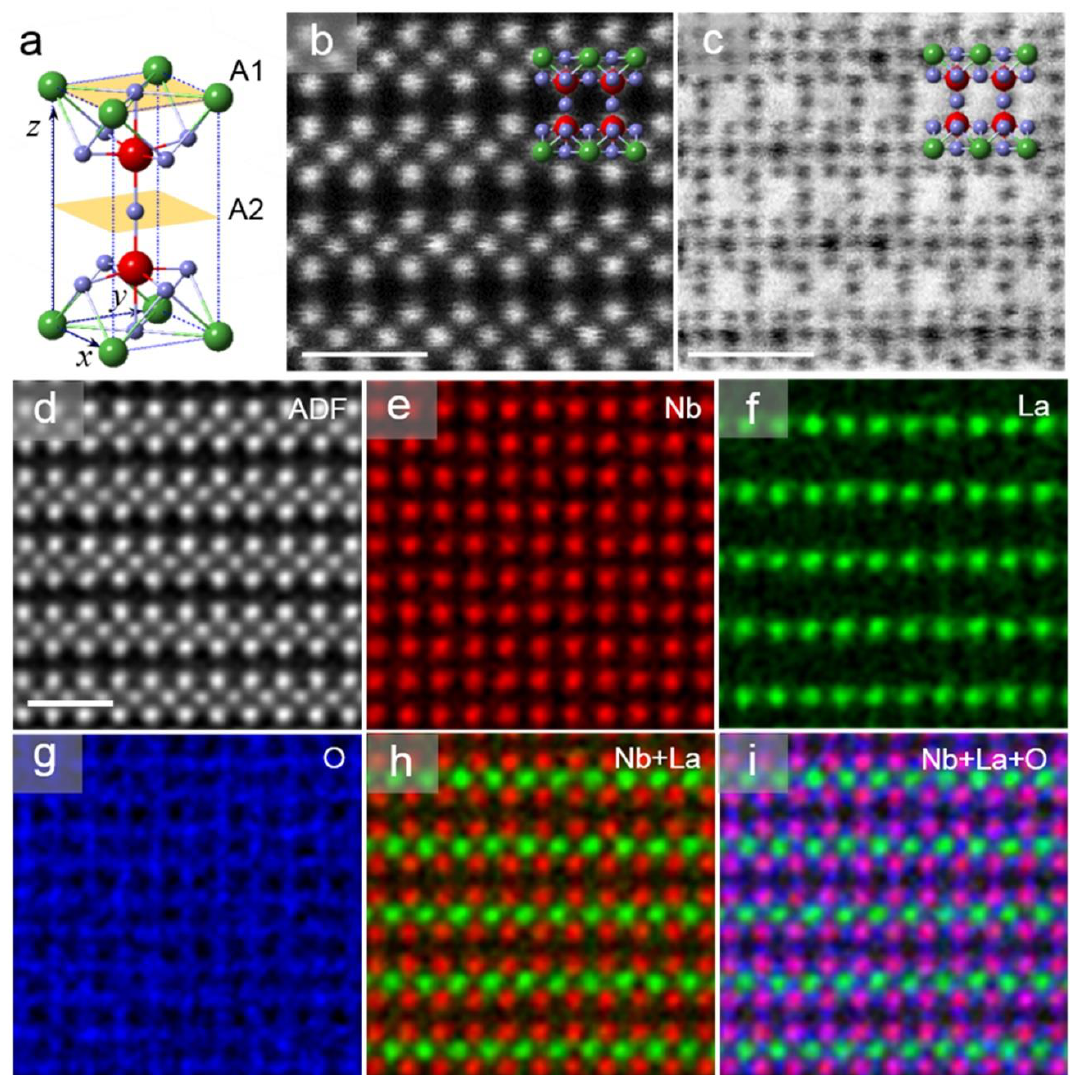
Figure 1. ( a ) Structure model of perovskite electrolyte LLNO. In the unit cell, green atoms stand for coexisting Li, La sites with an occupancy of 2/3, red for Nb with 100% occupancy, and blue for O with 100% occupancy. The A 1 layer marks the La, Li-coexisting layer, and A 2 layer is the “empty” mid-plane gap between A 1 layers. ( b , c ) Atomically resolved HAADF and ABF images in [100] direction, respectively. The atomic models superposed suggest the invisible O atoms can be clearly identified in the ABF image. ( d – i ) STEM-EDX mappings to reveal the chemical structure. Atomic resolution EDX mapping depicts the layered distribution of La in A 1 plane which is partly replaced by Li ions. Scale bars: 1 nm.